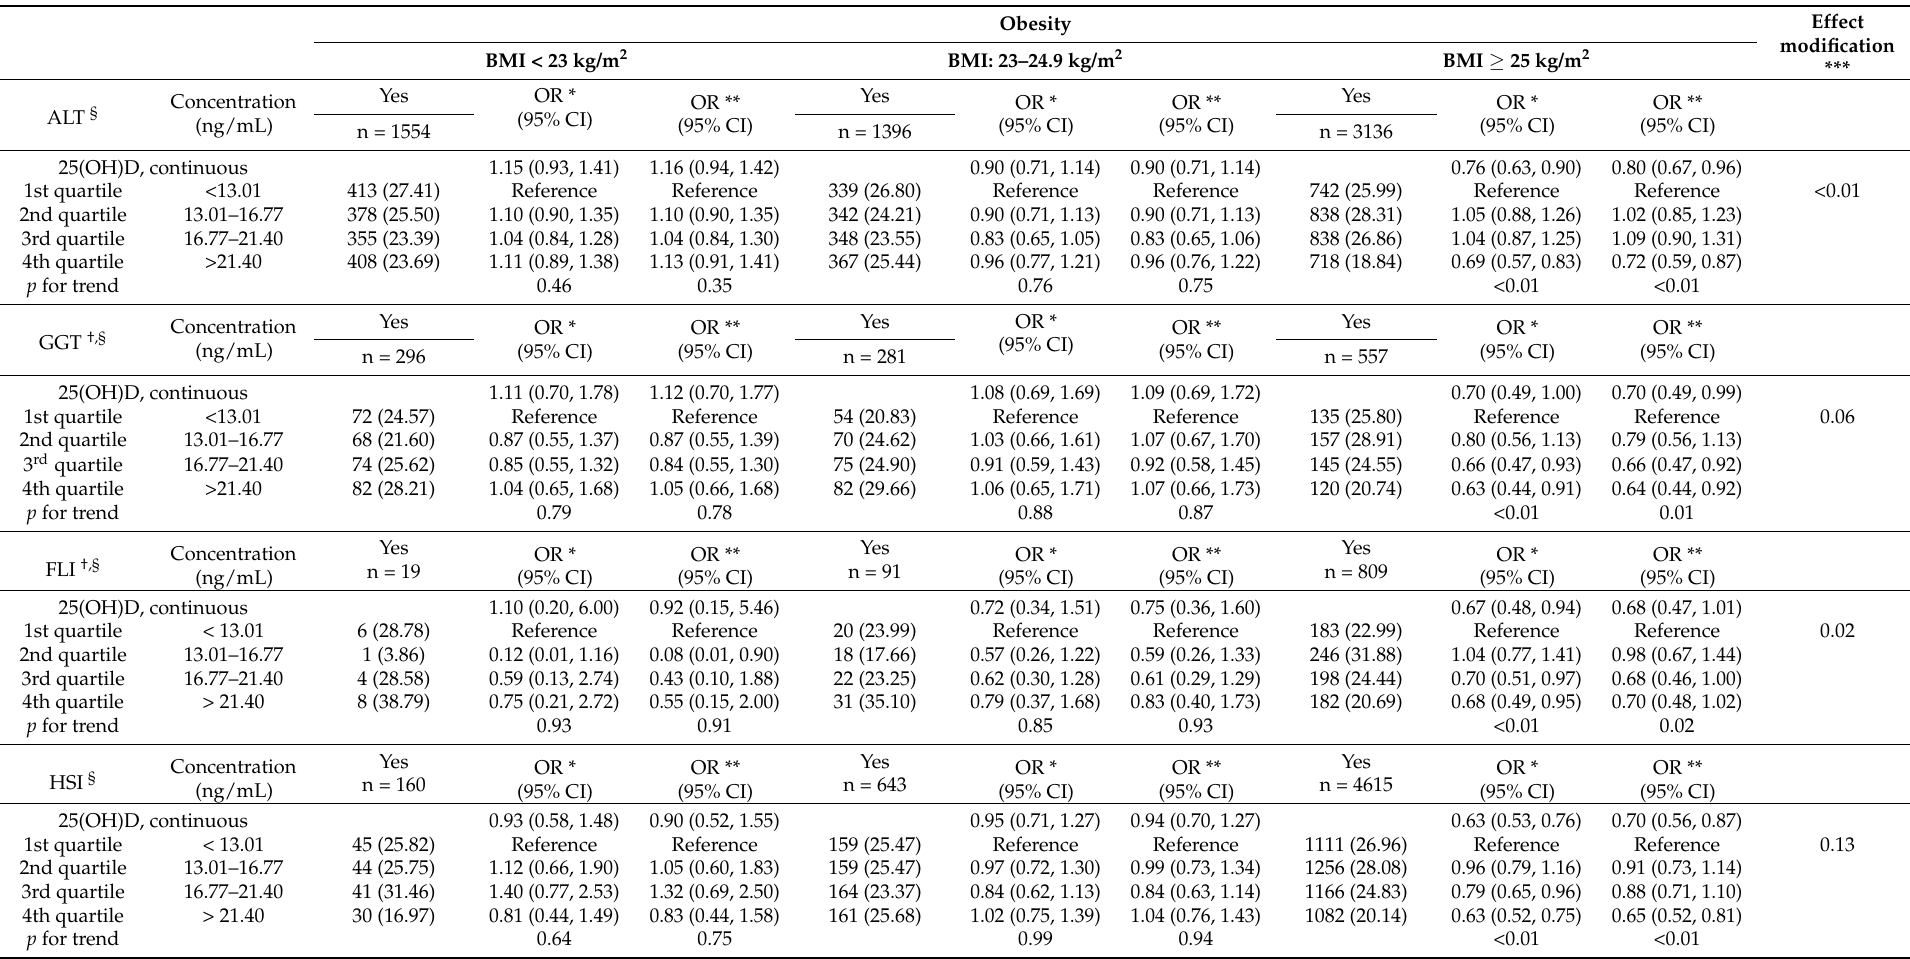
Table 4. Associations between serum 25(OH)D levels, elevated serum liver enzymes, and NAFLD indices, stratified by obesity.